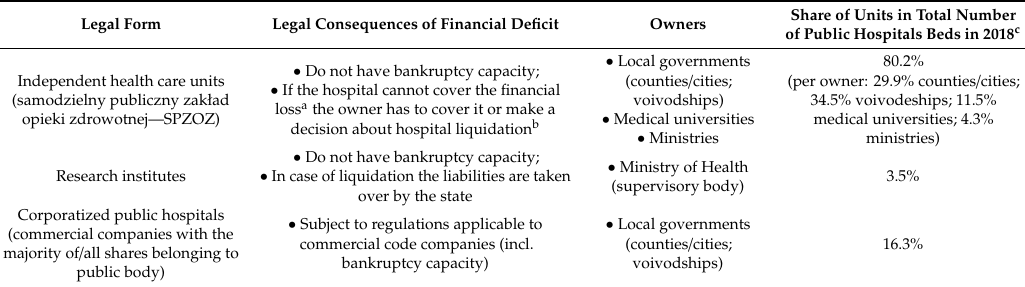
Table 1. Legal / organizational forms of public hospitals in